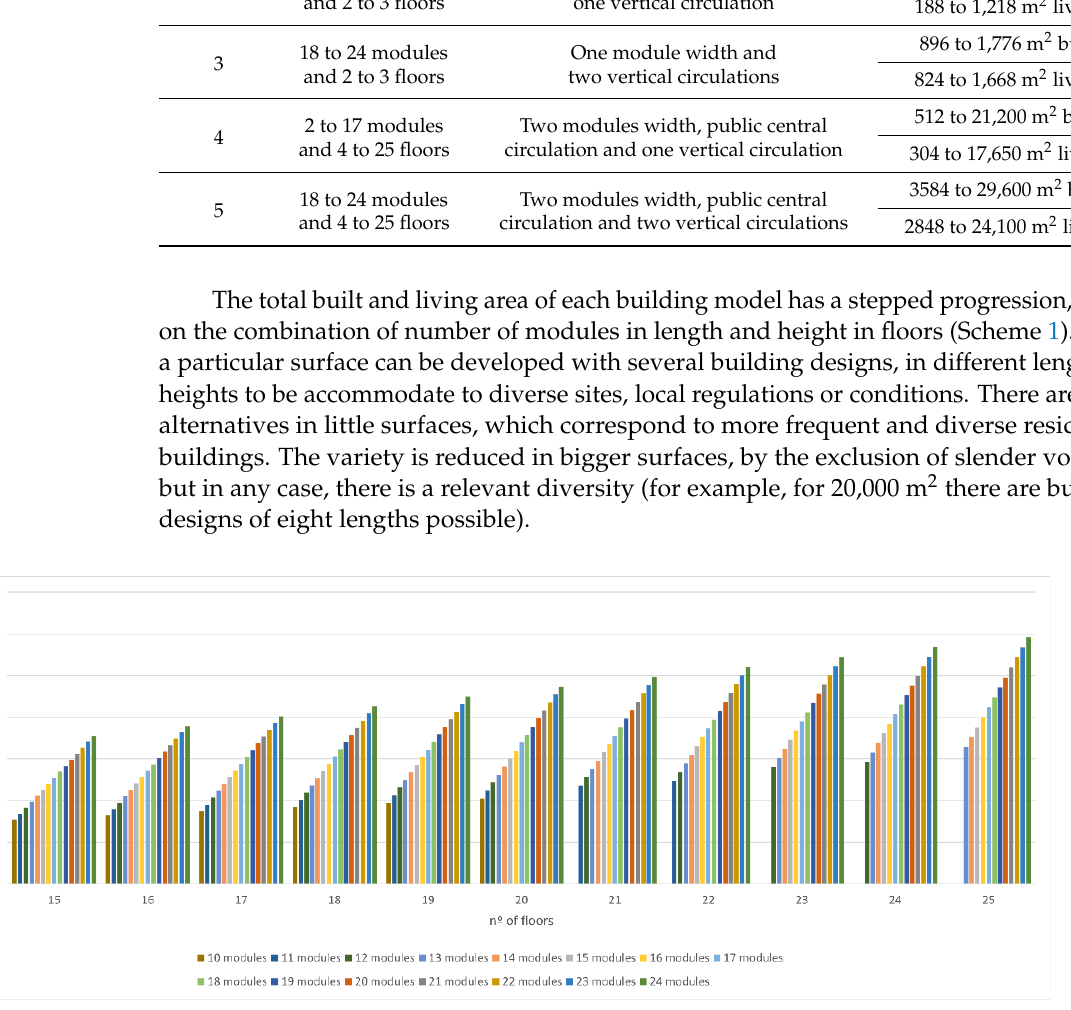
Table 2. Design Conditions of the Building